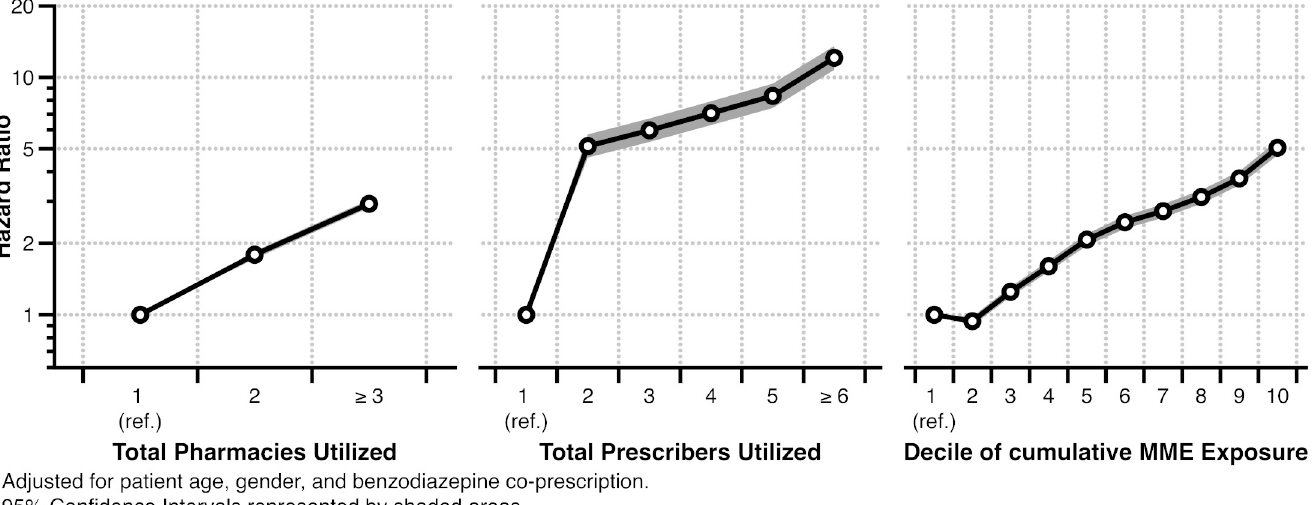
Fig 4. Multivariate adjusted Hazard Ratios of first buprenorphine initiation among North Carolina opioid analgesic recipients, 2011-2015. Note that the Hazard Ratios are plotted on a logarithmic scale.